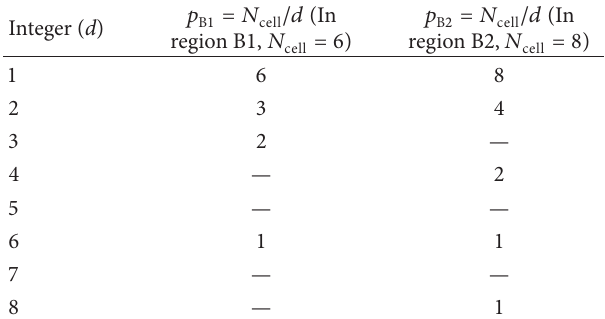
Table 1: Calculation of p for flux distribution B